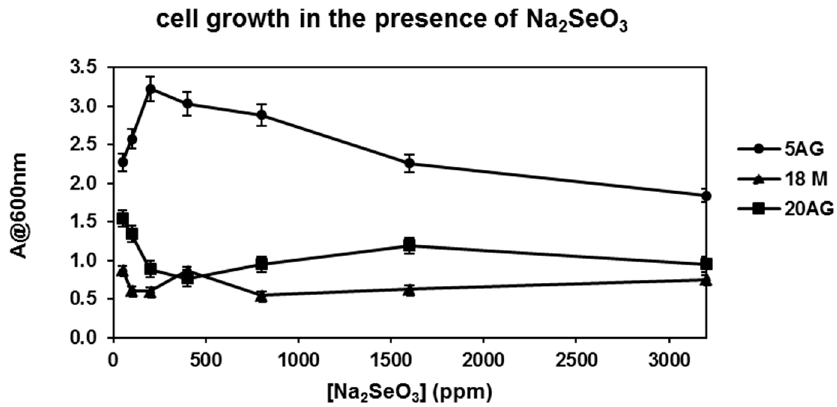
Figure 6. Haloalkaliphilic strain growth in medium A in the presence of Na 2 SeO 3 . Experiments were carried out at 36 °C and 200 rpm for 24 h. The cellular growth was monitored by measuring the solutions’ optical density at 600 nm.